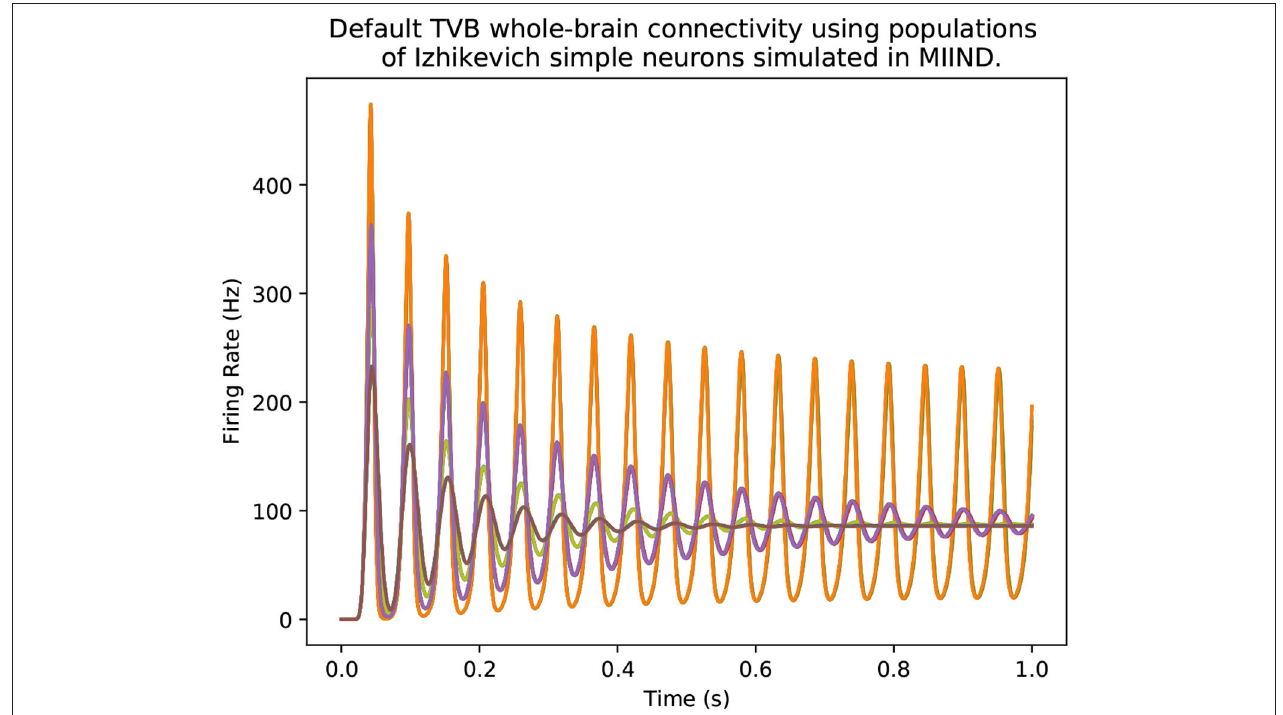
FIGURE 13 | The firing rates of 76 nodes from the default TVB connectivity simulation. Each node is a population of Izhikevich simple neurons simulated using MIIND. The majority of nodes produce oscillations which decay to a constant average firing rate. However, a subset of nodes remain in an oscillating